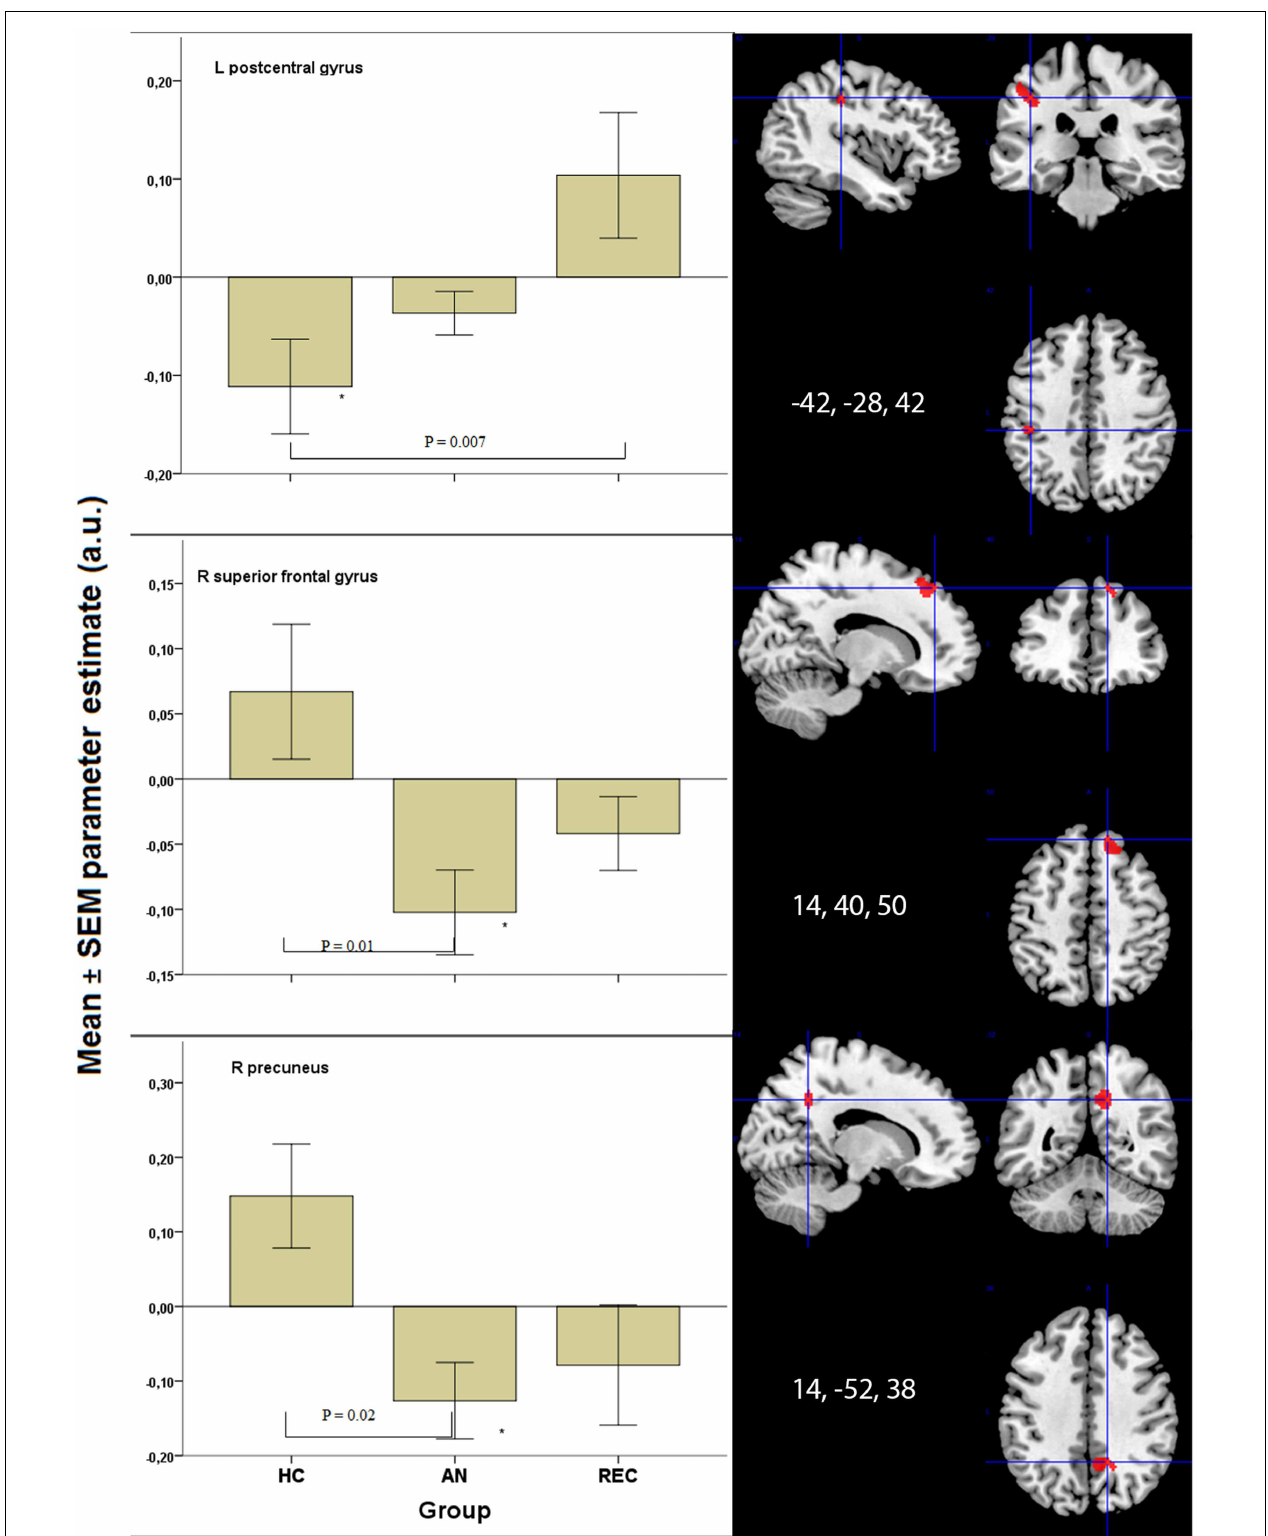
FIGURE 3 | Significant results in visual processing areas . * p < 0.05 when comparing food to non-food images. HC, healthy control; AN, Anorexia Nervosa; REC, recovered group; SEM, standard error of the mean; a.u., arbitrary